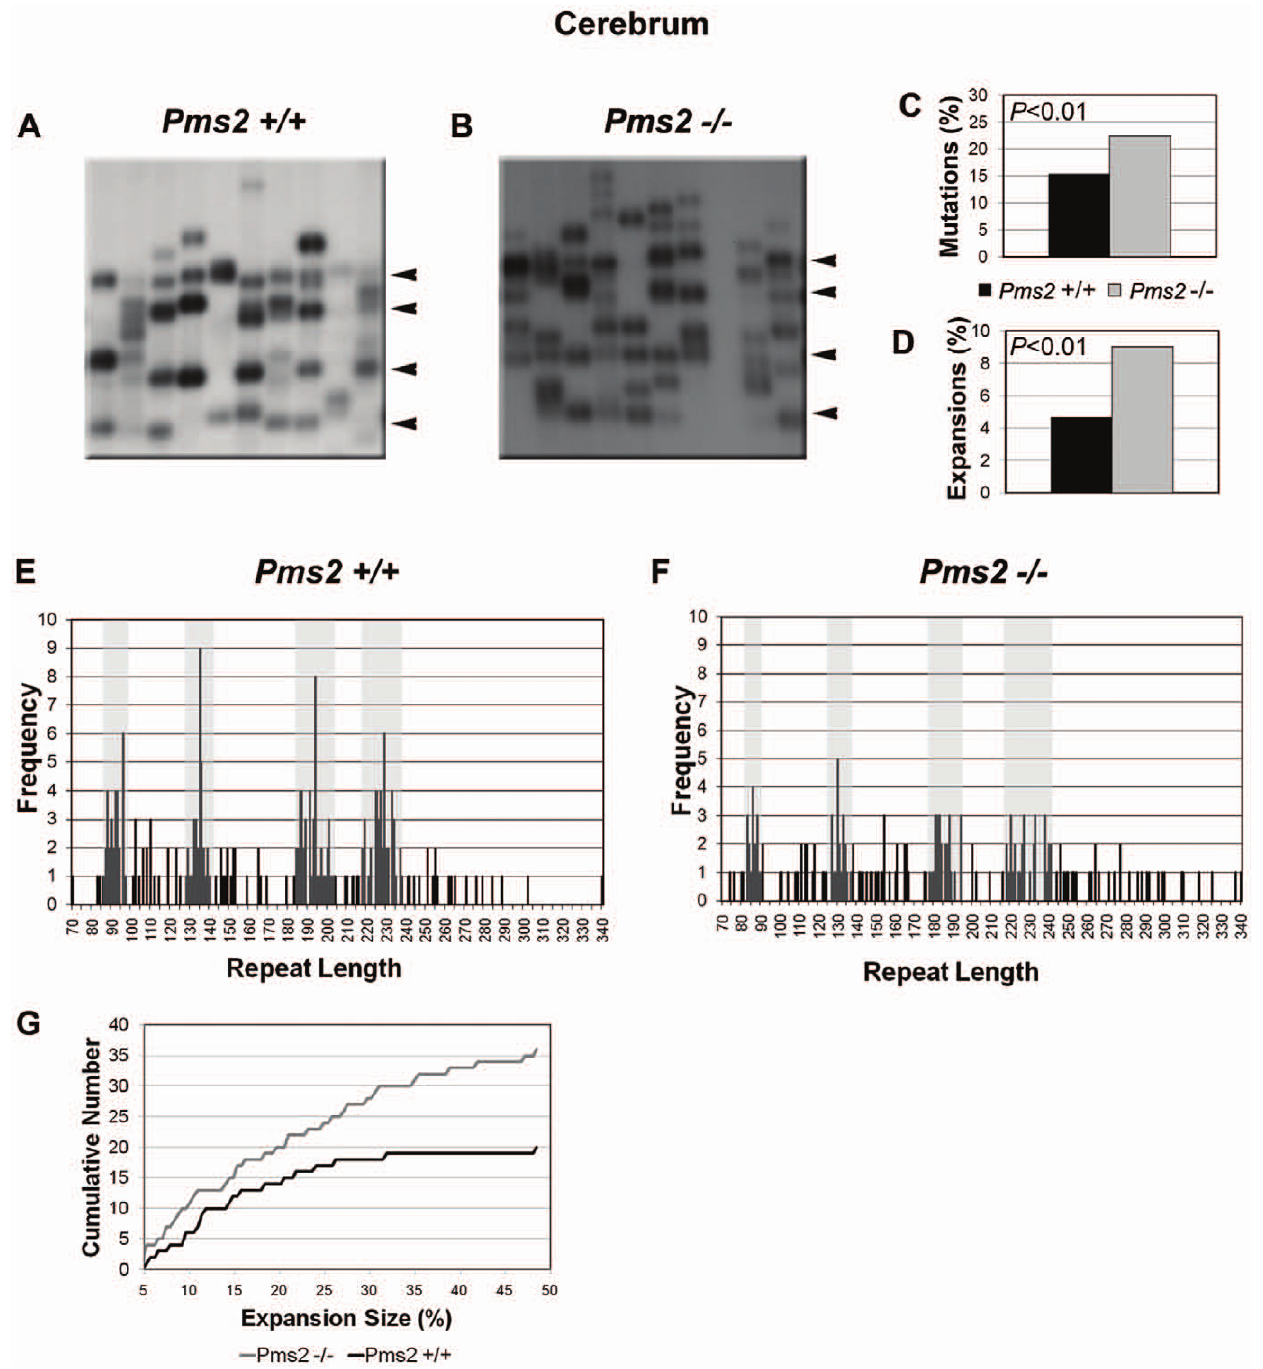
Figure 2. Absence of Pms2 increases somatic expansion load of the (GAA ? TTC) n sequence in cerebrum. Analysis of instability in cerebrum of Pms2 + / + and Pms2 2 / 2 mice. Representative autoradiographs from (A) Pms2 + / + and (B) Pms2 2 / 2 cerebrum are shown. Progenitor allele lengths of 229, 194, 135, and 94 repeats for Pms2 + / + and 229, 185, 130, and 86 repeats for Pms2 2 / 2 are indicated by arrowheads at the right of each panel. Mutation load and expansion load, quantified from the analysis of , 550 molecules per genotype, are shown in panels C and D, respectively. Panels E and F indicate the distribution of repeat lengths for all SP-PCR products of (E) Pms2 + / + and (F) Pms2 2 / 2 . These graphs are therefore an exact, combined representation of all blots analyzed for Pms2 + / + and Pms2 2 / 2 cerebrum. The number of products measured at each repeat length is on the Y-axis. Note that the actual frequency of products at the progenitor lengths may be slightly higher than the counted frequency, because a single band may represent PCR products amplified from multiple progenitor molecules. The gray bands represent the progenitor allele lengths + / 2 5%. Lines within the gray bands represent unchanged bands. Lines outside of these ranges represent mutations. Those to the right of the rightmost band represent expansions, those to the left of the leftmost band represent contractions, and those in the middle represent unclassified mutations. Panel G shows the cumulative number of products observed with increasing expansion size. Expansion size was calculated as the percent increase in repeat length above the largest progenitor. An incremental increase is seen in Pms2 2 / 2 versus Pms2 + / + mice at all expansion sizes, but the increase in magnitude of the difference at higher expansion sizes points to the role of Pms2 in preferentially suppressing large expansions in the cerebrum. doi:10.1371/journal.pone.0047085.g002 PLOS ONE |